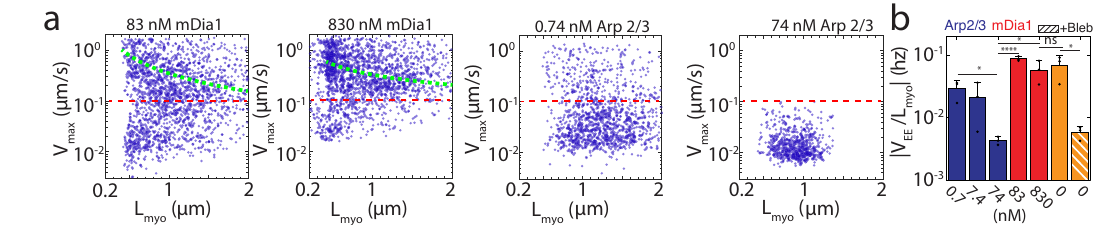
Fig. 7 | mDia1- and Arp 2/3-nucleated F-actin networks differentially constrain myosinthick fi laments.a Filamentmaximumspeed( v max )asafunctionofmyosin thick fi lament length ( L myo ) on networks of different architectures and density. Green dashed curves are ‘ guide to eye ’ for the inverse relationship. Myosin thick fi laments are considered as immobile (pixel resolution = 0.1 μ m) below the red dashed lines. b Absolute value of the slope of mean speed v EE vs L myo for all